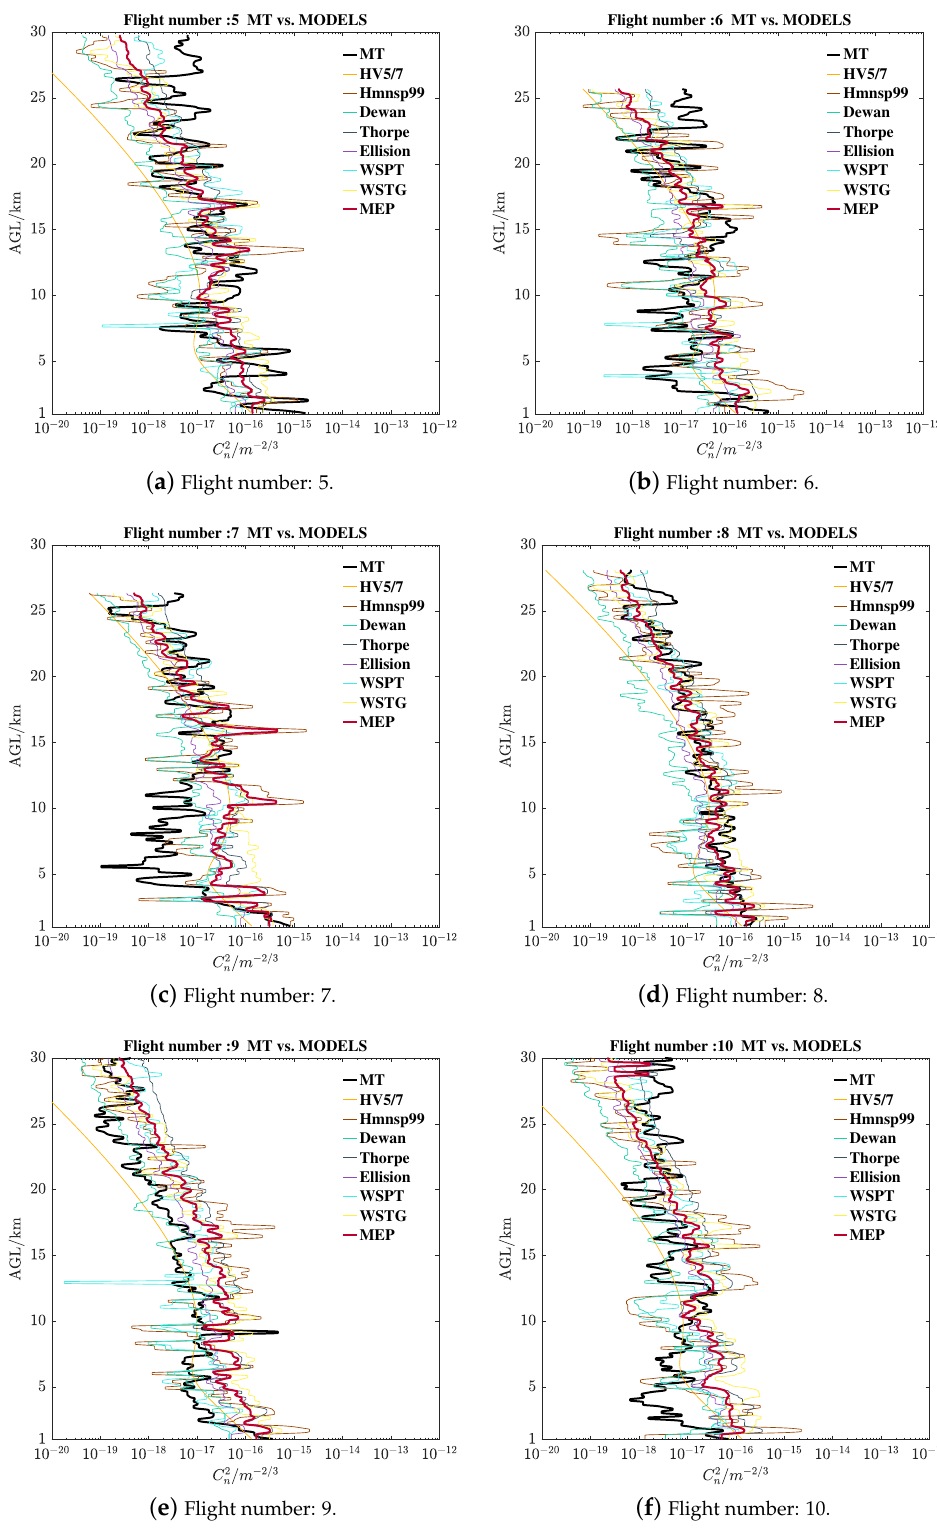
Figure A2. The refractive index structure parameter profiles of MT and estimations in ECACN: Figure A2 sub-figures ( a – f ) are flight numbers 5–10 in Table